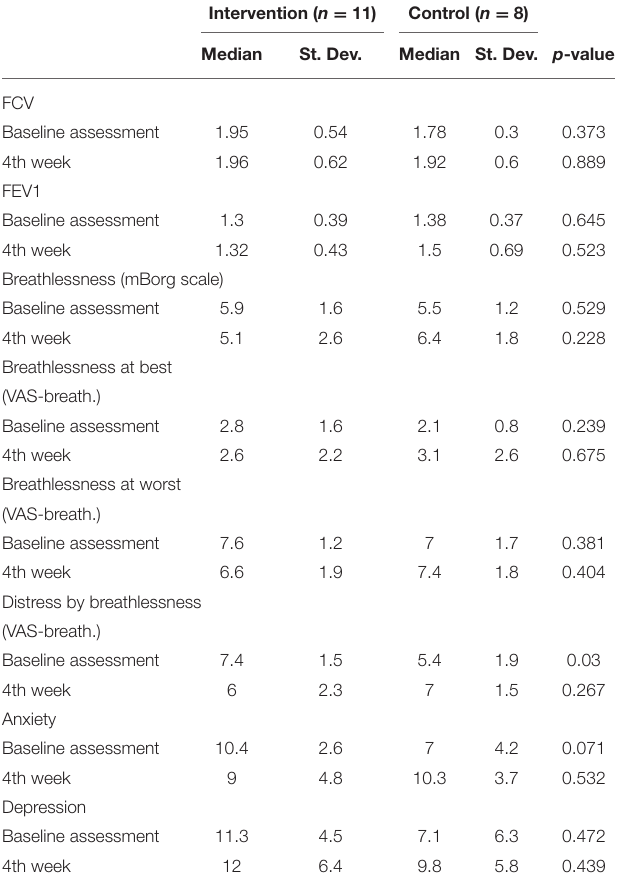
TABLE 5 | Patients’ measurements at baseline assessment and final assessment.